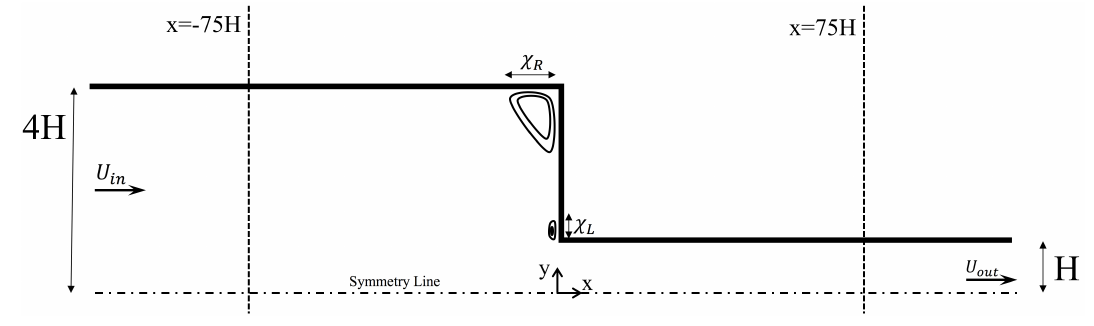
Figure 1. Planar 4:1 contraction